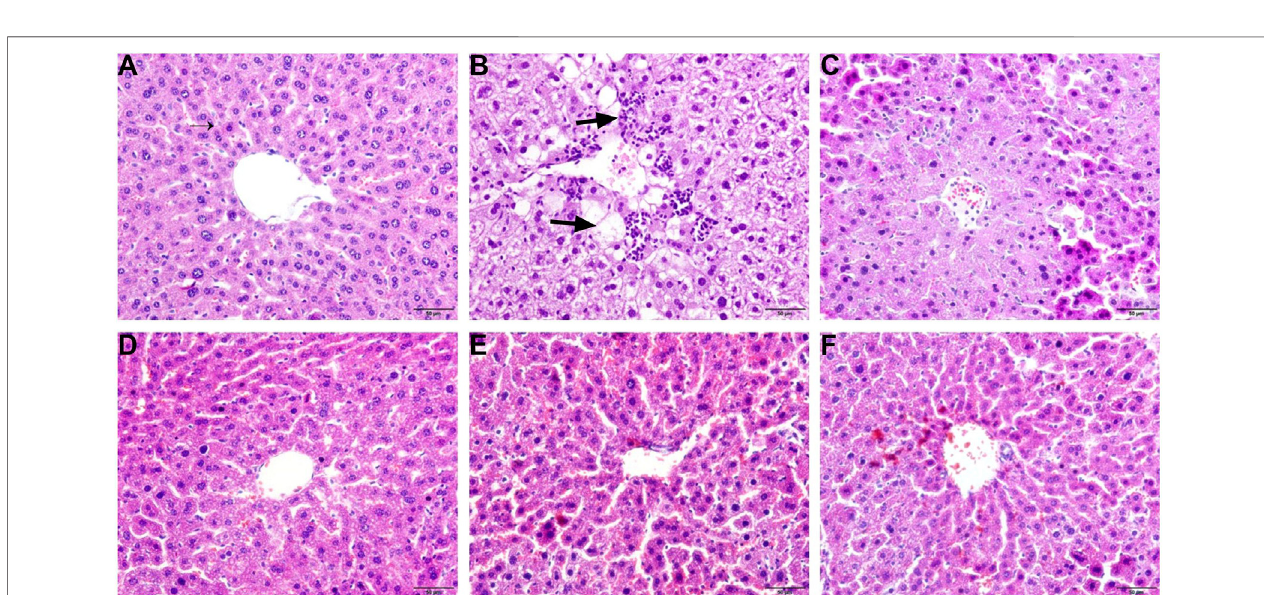
FIGURE 2 | ZDP ameliorates pathological changes of liver tissues in the CCl 4 -induced murine model of ALI. Sections were stained with HE and viewed at a magni fi cation of × 400. Scalebar (cid:1) 50 μ m. (A) Normal control; (B) Model control; (C) Bifendate control(0.0075 g/kg) (positivecontrol); (D) ZDP-L (0.625 g/kg); (E) ZDP-